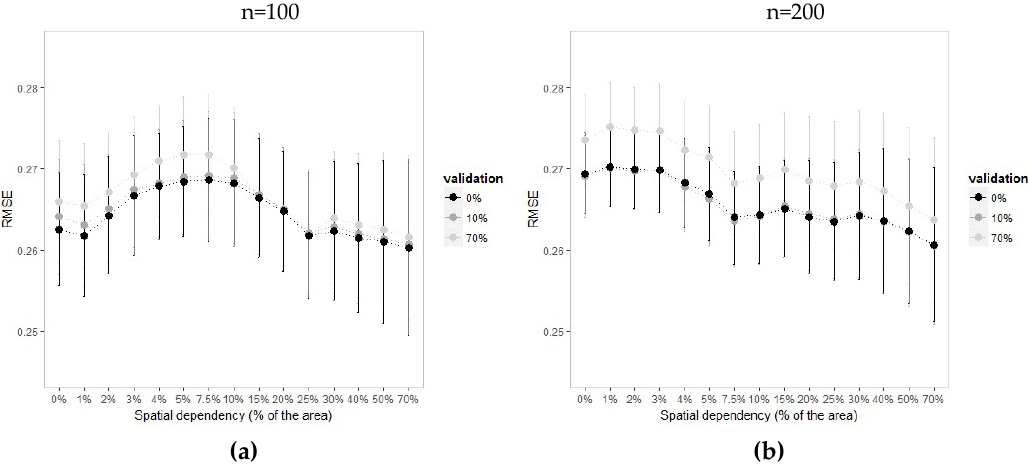
Figure A2. Mean and confidence intervals for RMSEtest across levels of spatial dependency for which models are making predictions (along the x-axis) when trained in landscapes with a spatial dependency of 0% (black), 10% (dark grey) and 70% (light grey) for different sample sizes. Linear models trained with the sample size of n = 100 ( a ) against a sample size of n = 200 ( b ). Linear models trained and tested with 100 observations present the highest RMSE (for the testing set), in landscapes with spatial dependency around 7.5% of the extent. This dependency